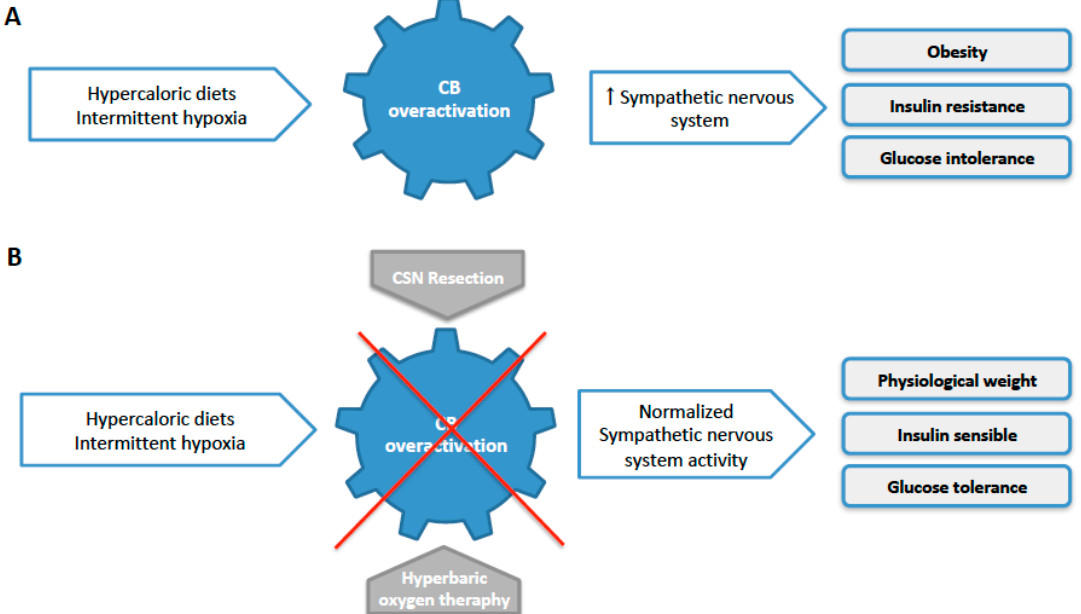
Figure 1. Schematic representation of the carotid body (CB) involvement in the development of obesity, insulin resistance, and glucose intolerance through an increase in sympathetic nervous system activity. ( A ) Hypercaloric diets and intermittent hypoxia promote an increase in CB activity that contributes to the augmentation of sympathetic nervous system activity, leading to metabolic dysfunction. ( B ) Modulation of CB activity through the carotid sinus nerve (CSN) resection or via hyperbaric oxygen therapy, normalized sympathetic nervous system activity, improving dysmetabolism.